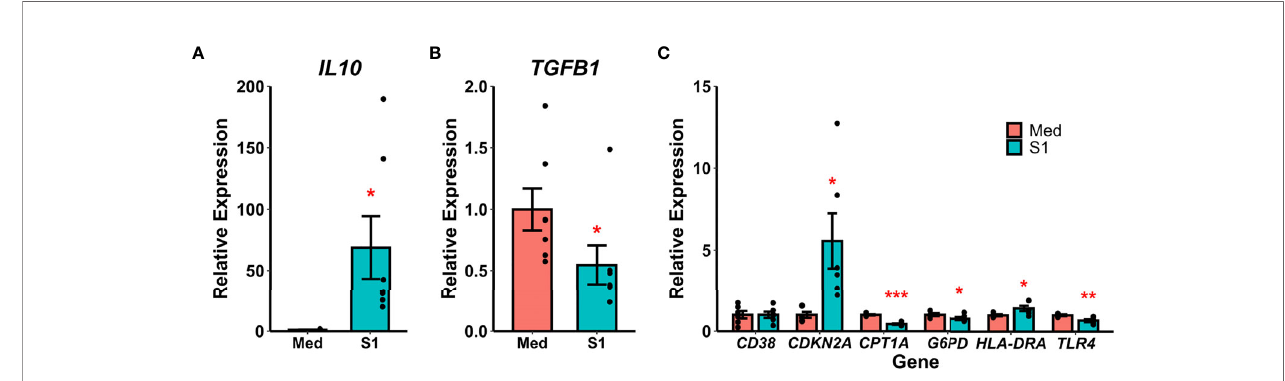
FIGURE 2 | Recombinant SARS-CoV-2 spike protein subunit 1 (S1) alters expression of anti-in fl ammatory cytokine and polarization-related genes. (A) S1 treatment increased expression of IL10 . (B) S1 treatment decreased expression of TGFB1 . (C) S1 increased expression of CDKN2A and HLA-DRA , while decreasing expression of CPT1A , G6PD , and TLR4 . *, *, ***p < 0.05, p < 0.01, p < 0.001 vs . media-treated cells. N = 7 biological replicates. Bars and error bars are mean